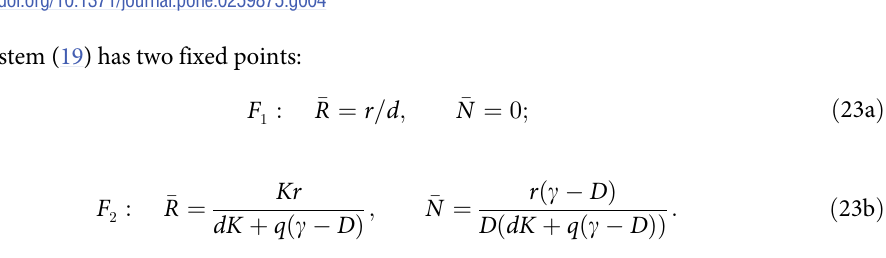
The phase portrait of Eq (19) is presented in Fig 5. The unpopulated steady state (23a) cor- responds to “washout” of the technology from the system; it always exists. Steady state (23b)